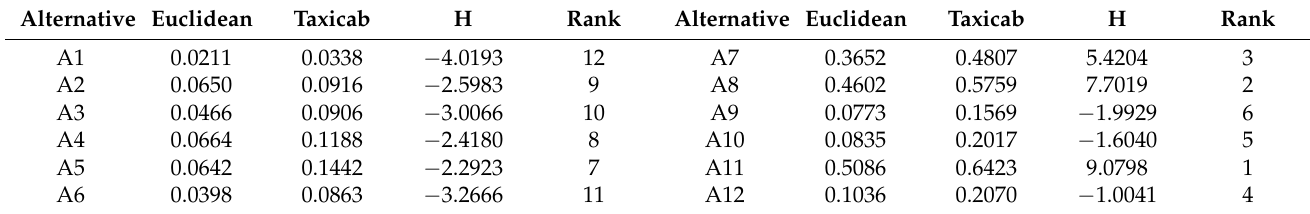
Table 5. Rank calculations using CODAS.